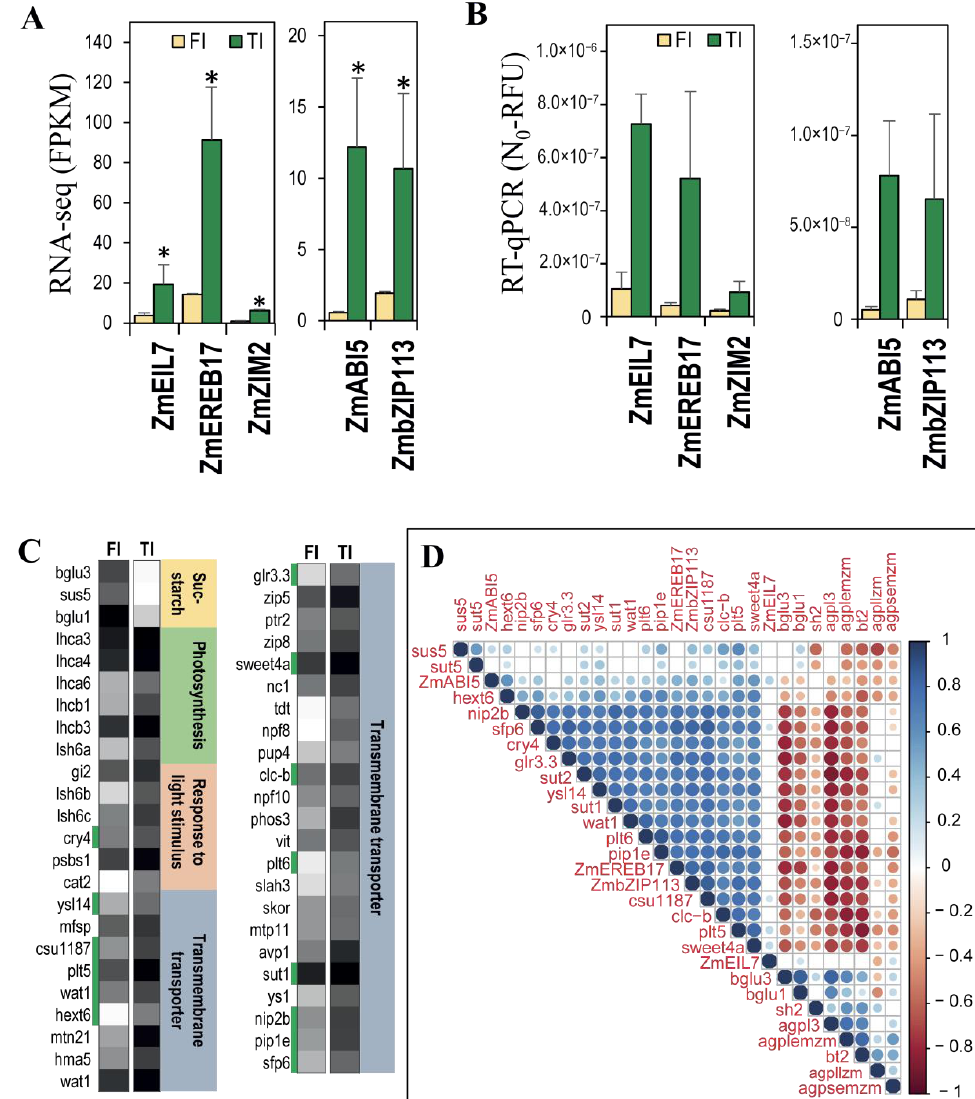
Figure 6. Validation of differentially expressed genes in the female inflorescence vs. top internode section of stem tissue. ( A ) Gene expression of transcription factors by RNA-seq and ( B ) validation by RT-qPCR; * significant differentially expressed, FDR < 0.05. ( C ) Differentially expressed genes from our RNAseq experiment for enriched GO terms related to sucrose–starch metabolism in the female inflorescence (FI) and the top internode (TI); green marks refer to the large cluster formed in the correlation graph in ( D ); FDR < 0.05. ( D ) Expression correlation of differentially expressed transcription factors, AGPase family, sucrose transporter, and transmembrane transporters from the maize B73 genome atlas. Spearman coefficient correlation (SCC), p -value < 0.01; colored circles correspond to the significant correlations; non-significant correlations are blank